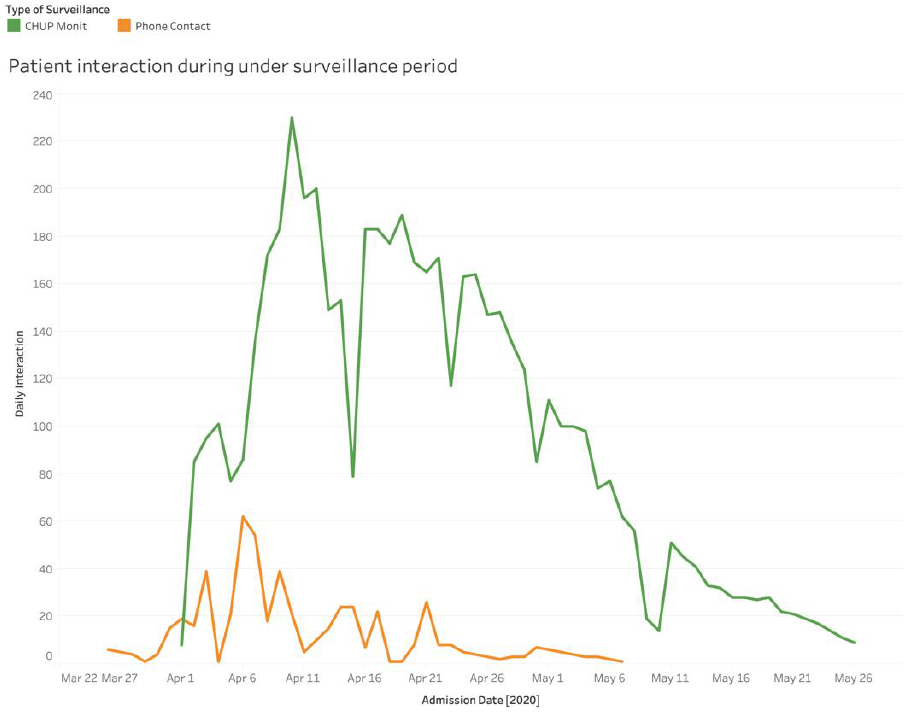
Figure 7. Average daily interaction with CHUP Monit and phone contact.